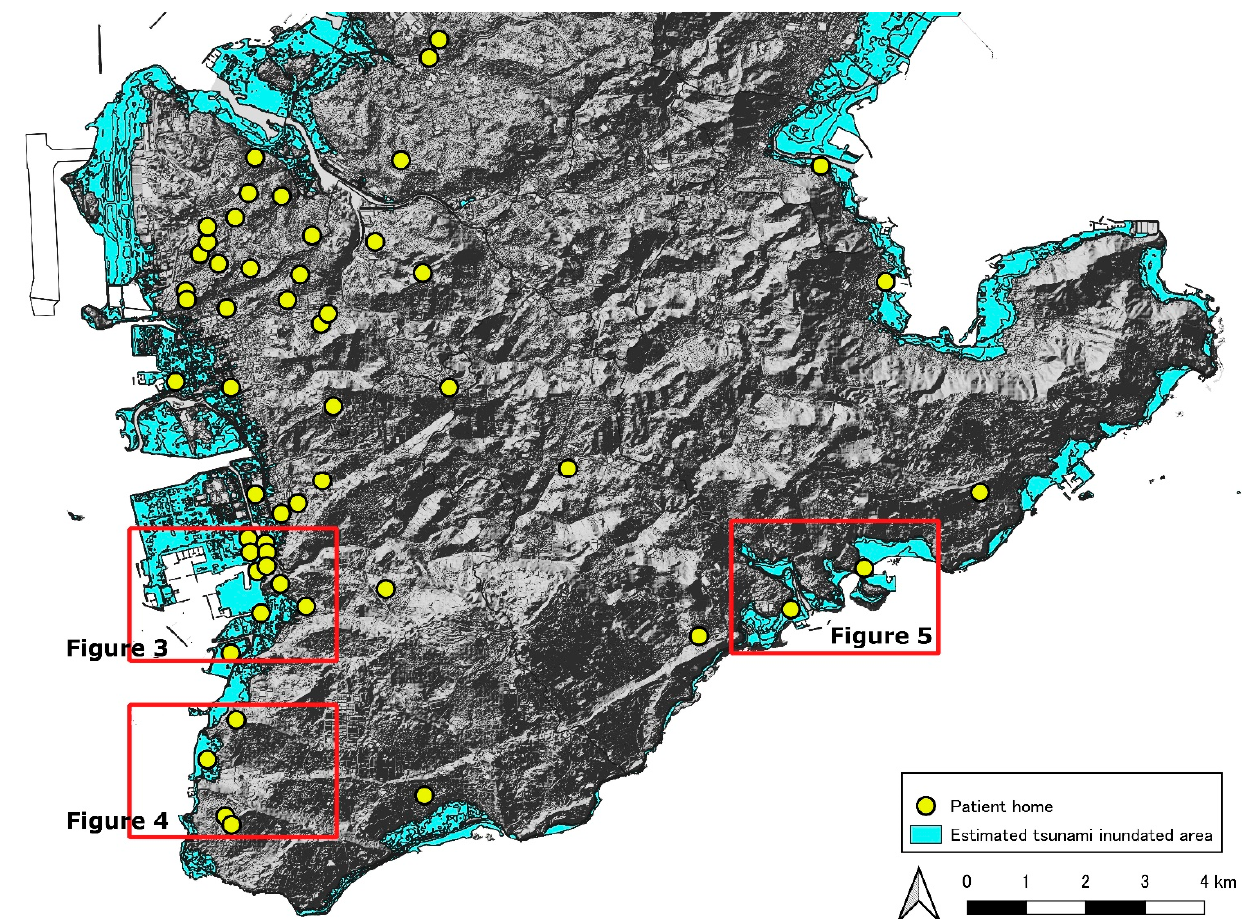
Figure 2. The locations of patients with chronic respiratory diseases with HOT who live in the southern areas of the main island of Okinawa.